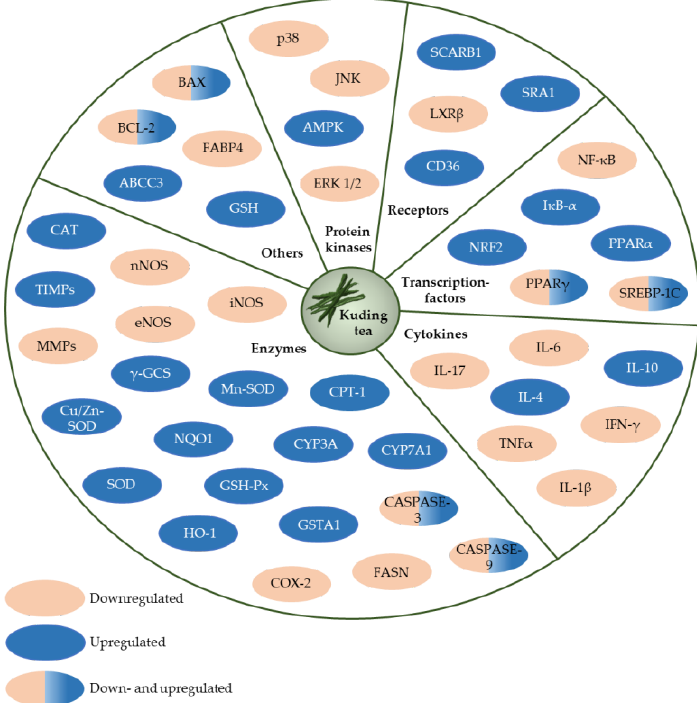
Figure 8. Potential molecular targets of large-leaved Kudingcha.These include, ABCC3, ATP-binding cassette, subfamily C, member 3; AMPK, AMP-activated protein kinase; BAX, BCL2-associated X protein; BCL-2, B cell leukemia/lymphoma 2; CASPASE-3, caspase 3; CASPASE-9, caspase 9; CAT, catalase; CD36, CD36 molecule; COX-2, cyclooxygenase-2; CPT-1, carnitine palmitoyltransferase 1; Cu/Zn-SOD, copper/zinc superoxide dismutase; CYP3A, cytochrome P450, family 3, subfamily a; CYP7A1, cytochrome P450, family 7, subfamily a, polypeptide 1; eNOS, endothelial nitric oxide synthase; ERK 1/2, extracellular signalling-regulating kinase 1/2; FABP4, fatty acid-binding protein 4; FASN, fatty acid synthase; GSH, glutathione; GSH-Px, glutathione peroxidase; GSTA1, glutathione S- transferase, alpha 1; HO-1, haem oxygenase 1; IFN- γ, interferon -gamma; IL-10, interleukin 10; IL-17, interleukin 17; IL- 1β, interleukin 1 beta; IL -4, interleukin 4; IL-6, interleukin 6; iNOS, inducible nitric oxide synthase; IκB - α, nuclear factor of kappa light polypeptide gene enhancer in B cells inhibitor; JNK, c-Jun N- terminal kinase; LXRβ, liver X receptor-beta; MMPs, matrix metalloproteases; Mn-SOD,